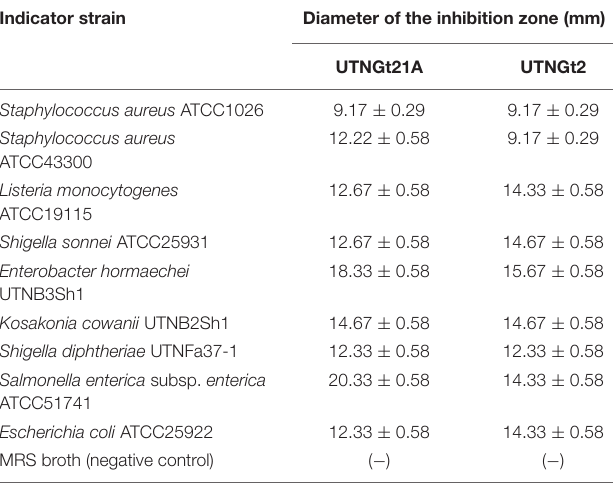
TABLE 4 | Inhibitory spectrum of CE obtained from UTNGt21A and UTNGt2 strains. Indicator strain Diameter of the inhibition zone (mm)